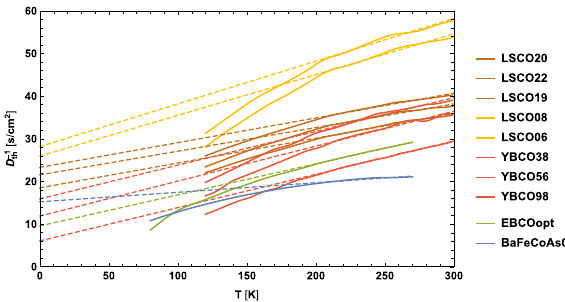
Fig. 1 Inverse thermal diffusivity for several high- T c compounds. Solids lines are data and the dashed lines show the intercept of the high temperature linear in T regime. Within each group (overdoped and underdoped LSCO 53,54 , a -axis YBCO 5,55 , EBCO 8,56 , and Ba- 122 6,57,58 ), the curves are in the order shown in the